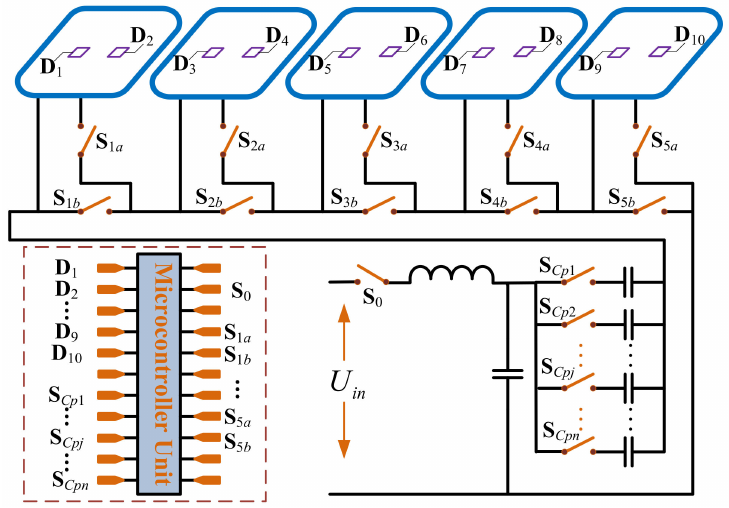
Figure 8. The topology design of the position detection and switching control in primary